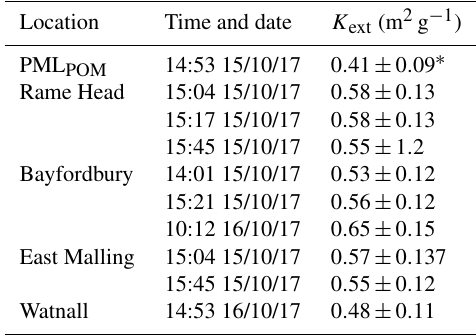
Table 1. Values of K ext calculated using sun-photometer data. Location